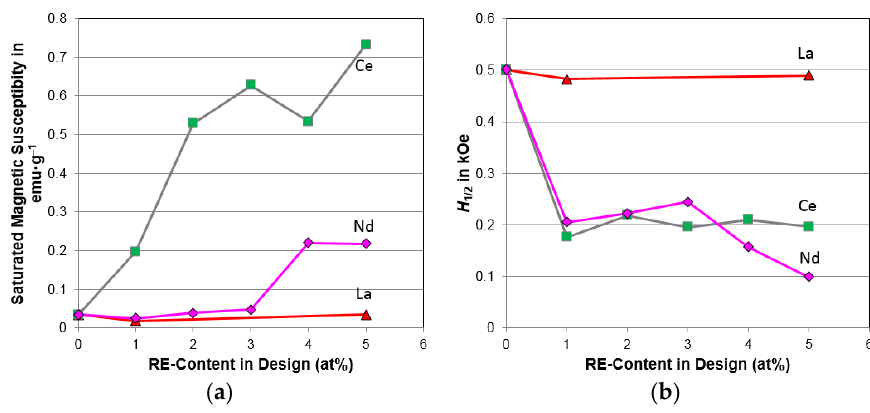
( c ) Figure 16. Evolutions of ( a ) surface charge-transfer resistance; ( b ) double-layer capacitance calculated from the AC impedance results measured at − 40 °C; and ( c ) their product with increasing RE-content in the design. 4.5. Magnetic Properties In most MH alloys, the HRD characteristics are heavily affected by the density of metallic Ni- inclusion embedded in the surface oxide [63–66]. Thus far, the Si-containing AB 2 MH alloys are the only type of alloy where the HRD performance is dominated by the clean oxide/metal interface but not the occurrence of metallic Ni [67]. Both the total saturated magnetic susceptibility ( M s , related to the total volume of metallic Ni-clusters) and applied field corresponding to half of M s (H 1/2 , inversely proportional to the average number of Ni atoms in a cluster) were calculated from the plot of measured M.S. versus applied magnetic field (as in [65]) and are listed in Table 6. As the Ce-content in the alloy increases, M s increases, and H 1/2 drops precipitously and then remains approximately the same. The Ce/CeNi phase in the Ce-containing alloys promotes the formation of metallic Ni-clusters embedded in the surface oxide with a size around two and half times larger than those in the Ce-free base alloy. When these two properties ( M s and H 1/2 ) are compared among all the RE-substitutions, as shown in Figure 17, the Ce-doped alloys have the highest M s values, which is in agreement of their high HRD (Figure 11b) and I o (Figure 13b) values. The La-substitution shows the lowest M s but still exibits comparable HRD to that of the Ce-substitution due to the unique clean interface between the